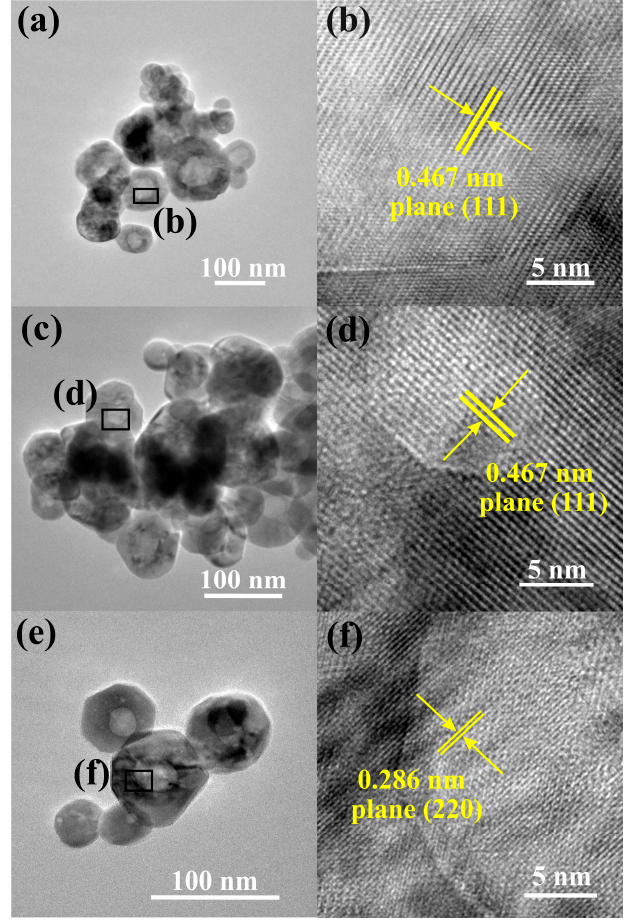
Figure 6. TEM and HRTEM images of the samples A ( a , b ); B ( c , d ); and C ( e , f ).